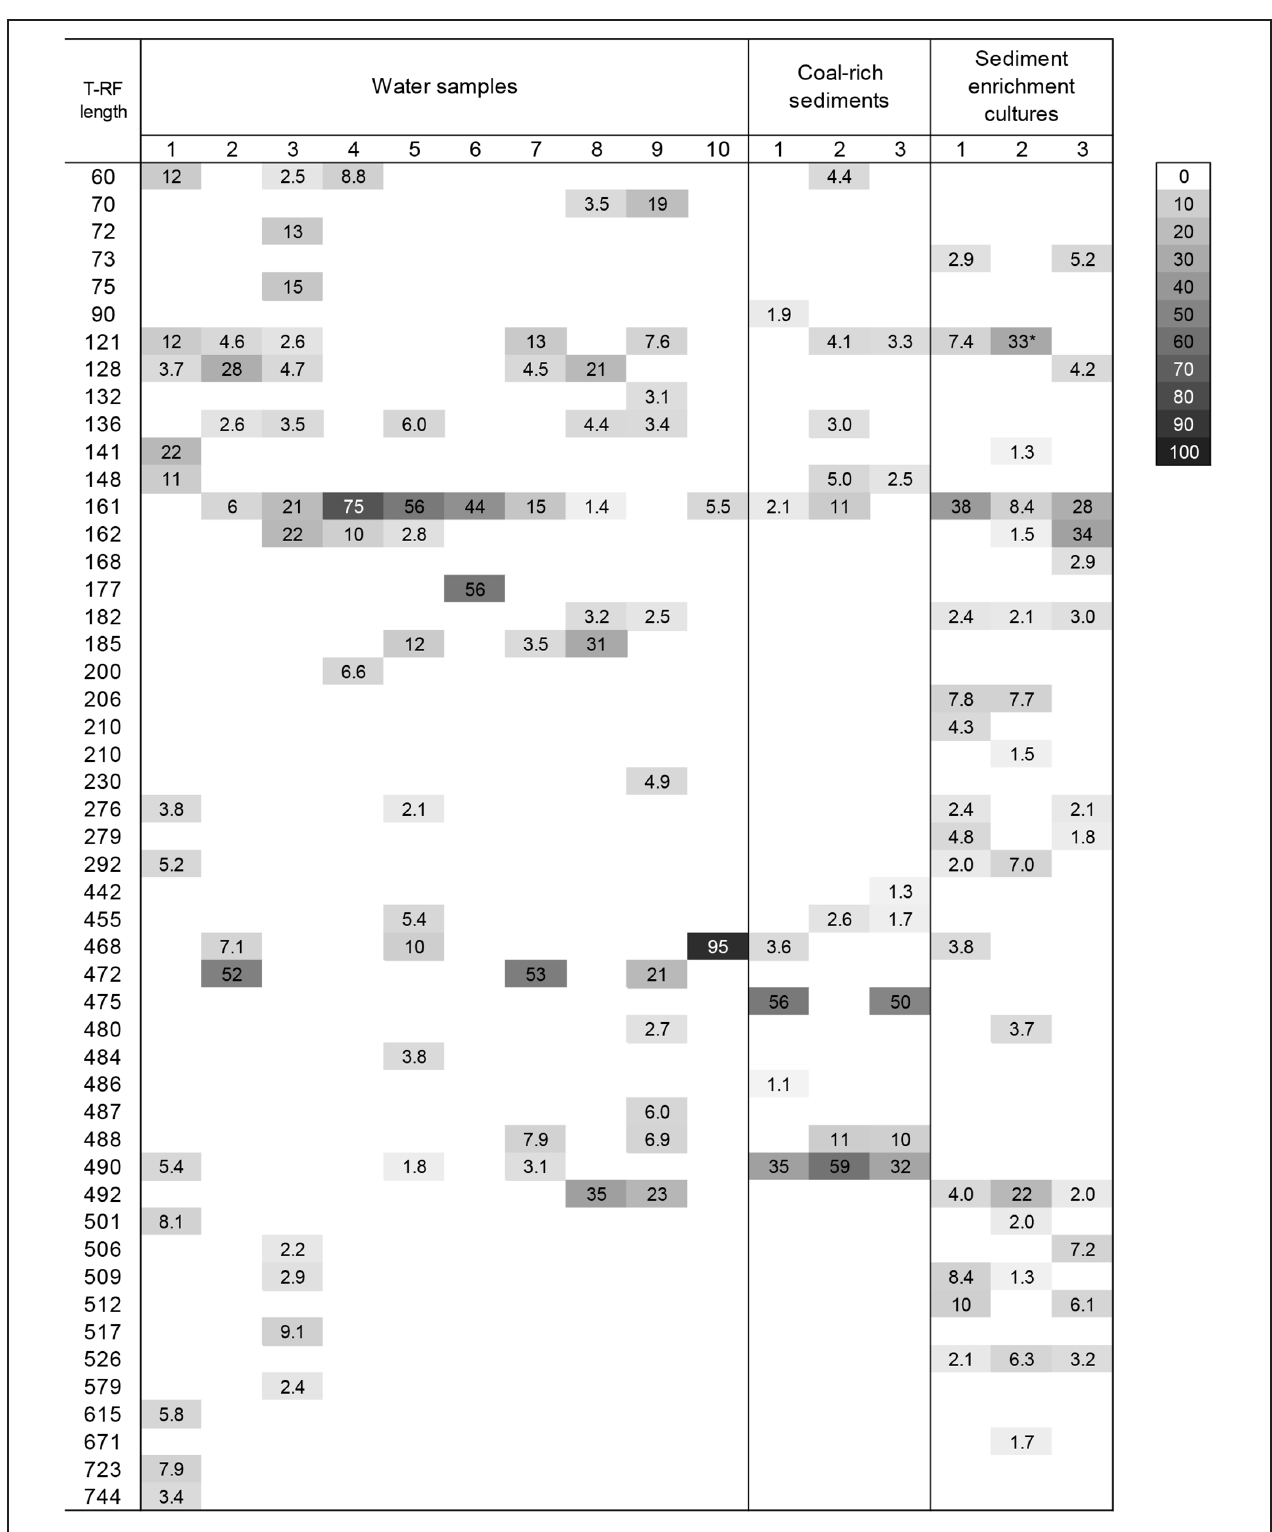
FIGURE 4 | Heatmap showing the T-RF found in Bacterial 16S rRNA gene T-RFLP fingerprints from different groundwater samples collected from deep aquifers of coal-rich sedimentary basin, coal-rich sediment samples, and the derived enrichment